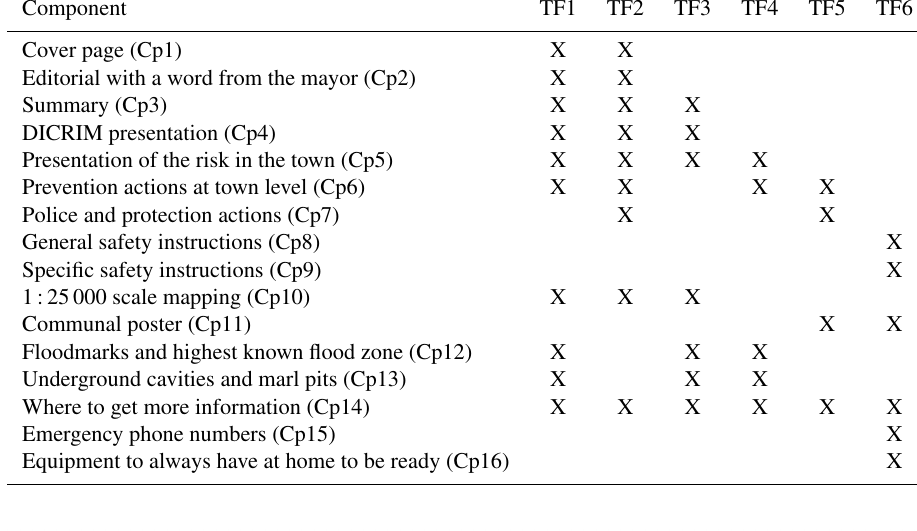
Table 5. Membership of each technical function identified for the 16 components (TF1: provide information to raise awareness of risk; TF2: provide information to drive knowledge on risk; TF3: provide information to foster the acceptance of risk; TF4: provide information to maintain risk memory; TF5: provide information on event detection; TF6: make known the appropriate responses to adopt if a phenomenon occurs).